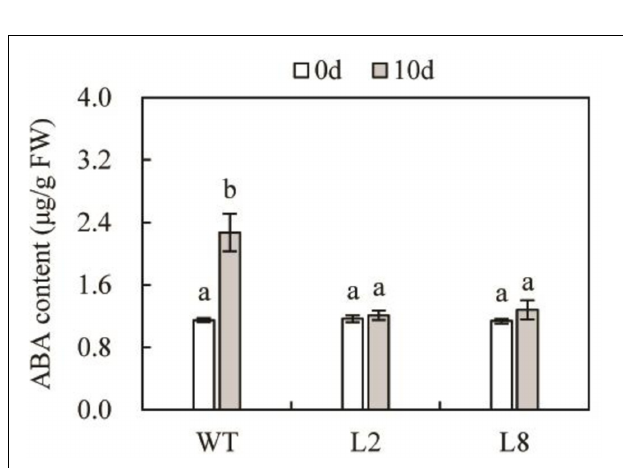
FIGURE 5 | The endogenous contents of ABA in WT and transgenic lines under control and drought treatment. Error bars represent SD and values with different letters are significant at P <